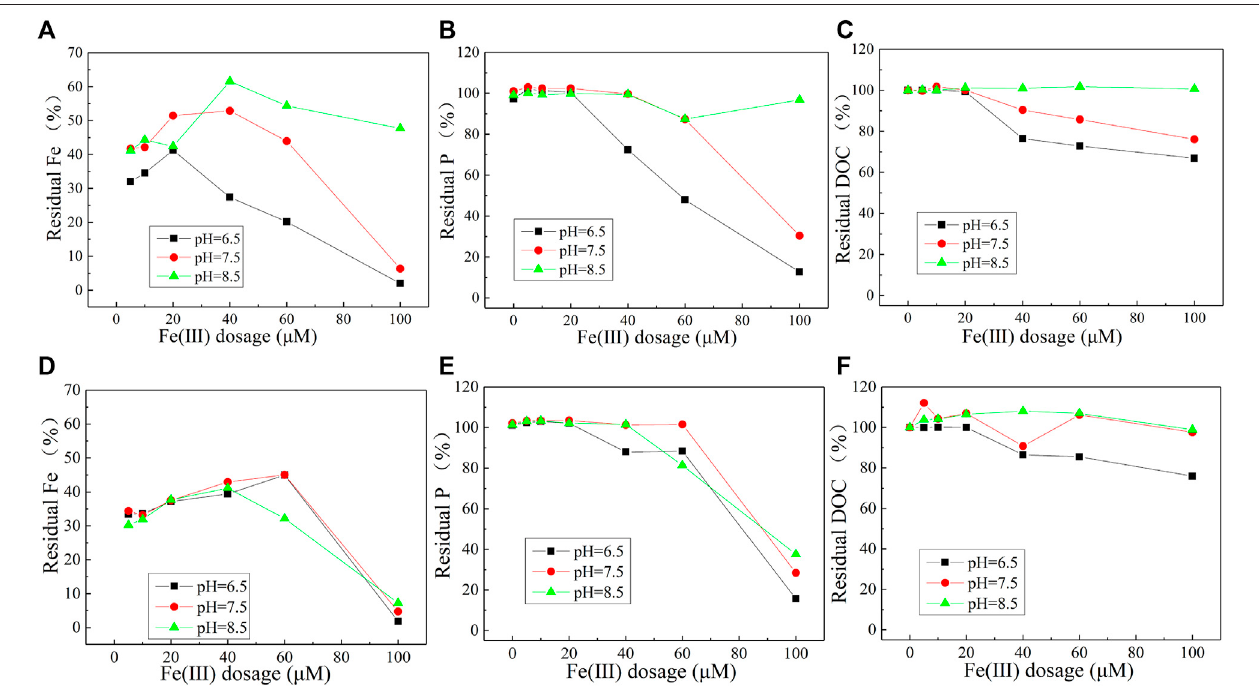
FIGURE 2 | Residual percentage of Fe (III) (A) , PO 43 − (B) , and DOC (C) after coprecipitation of M-WSOM with Fe and P at different pH values and residual percentage of Fe (III) (D) , PO 43 − (E) , and DOC (F) after A-WSOM coprecipitated with Fe and P at different pH values.